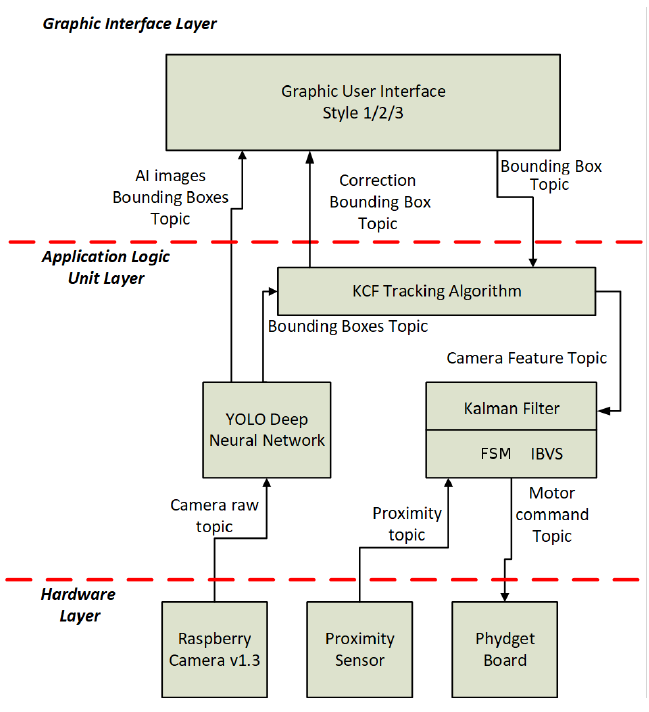
Figure 3. Layered structure of the system